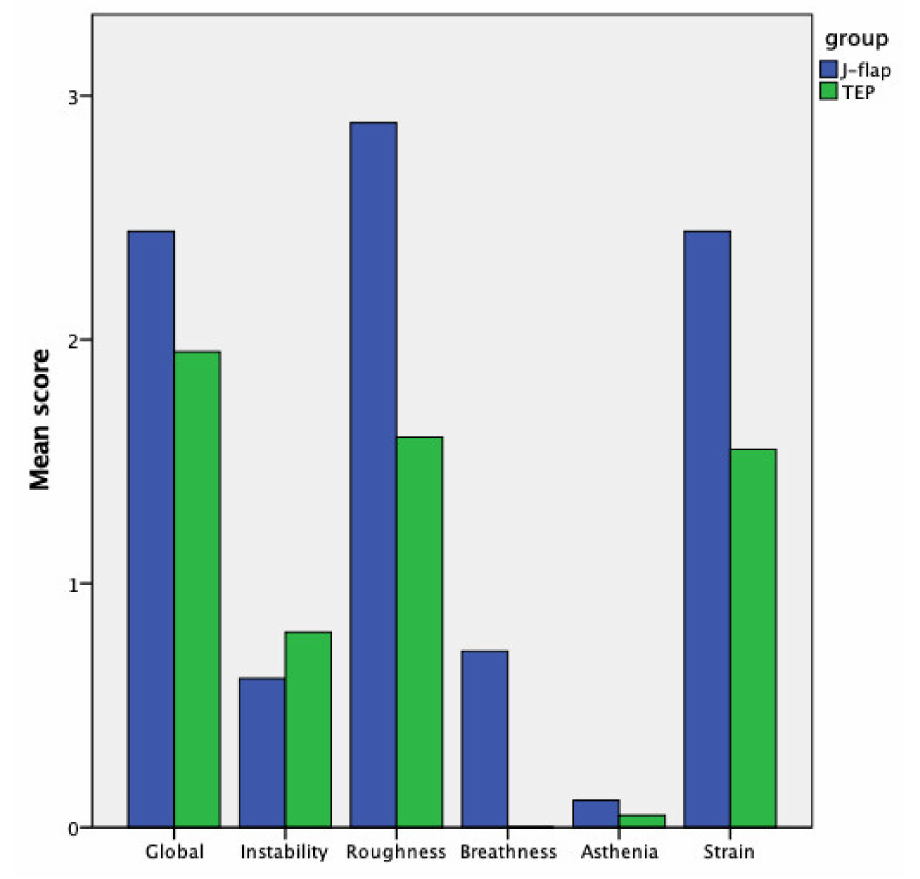
Figure 3. Dysphonia assessment—GIRBAS score. Table 2. Speech pathologist